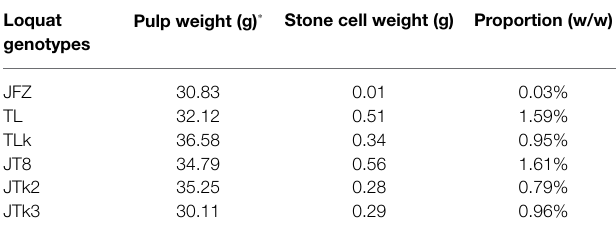
TABLE 1 | Stone cell contents in different loquat